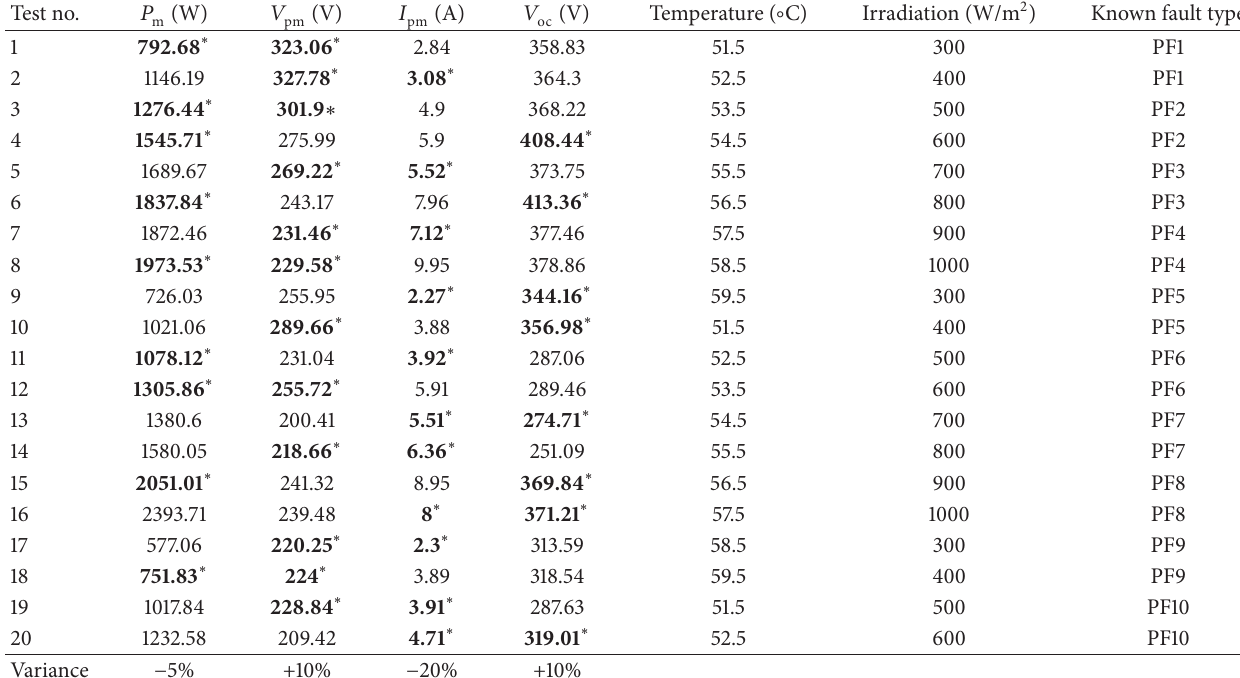
Table 10: Test data with additional errors under 300–1000 W/m 2 irradiation and PV module surface temperatures between 51 and 60 ∘ C. Test no.